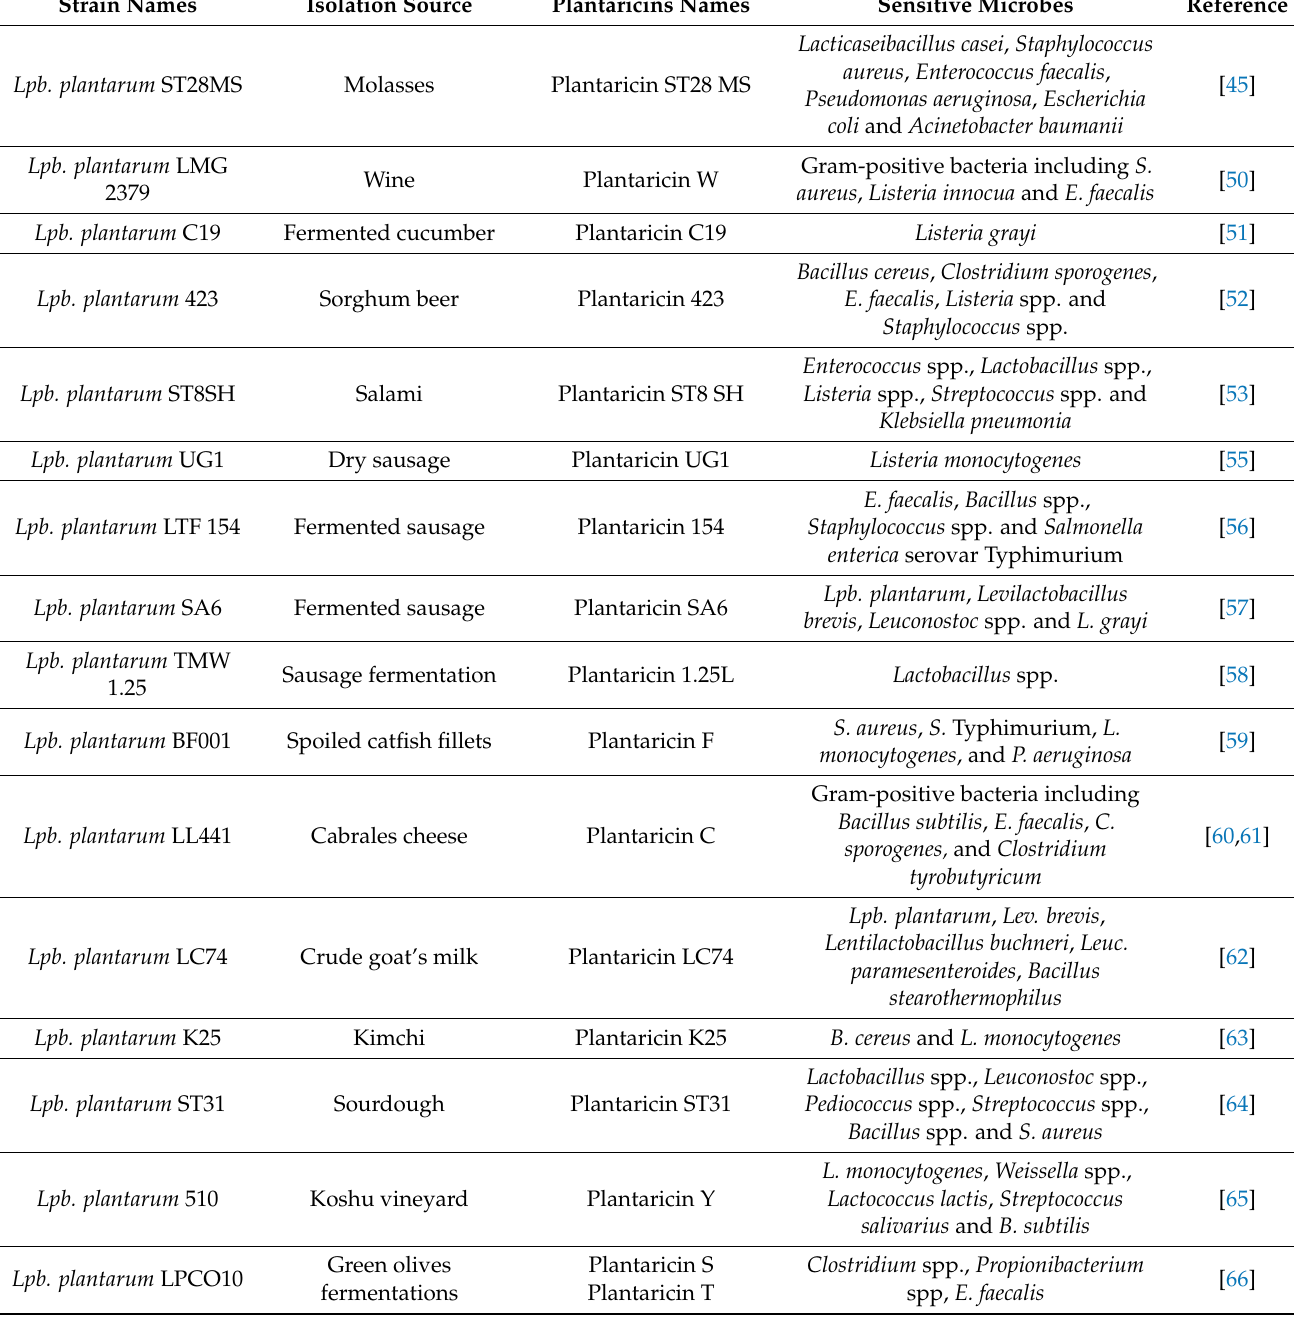
Table 1. Most characterized plantaricins produced by Lpb. plantarum strains isolated from various fermented